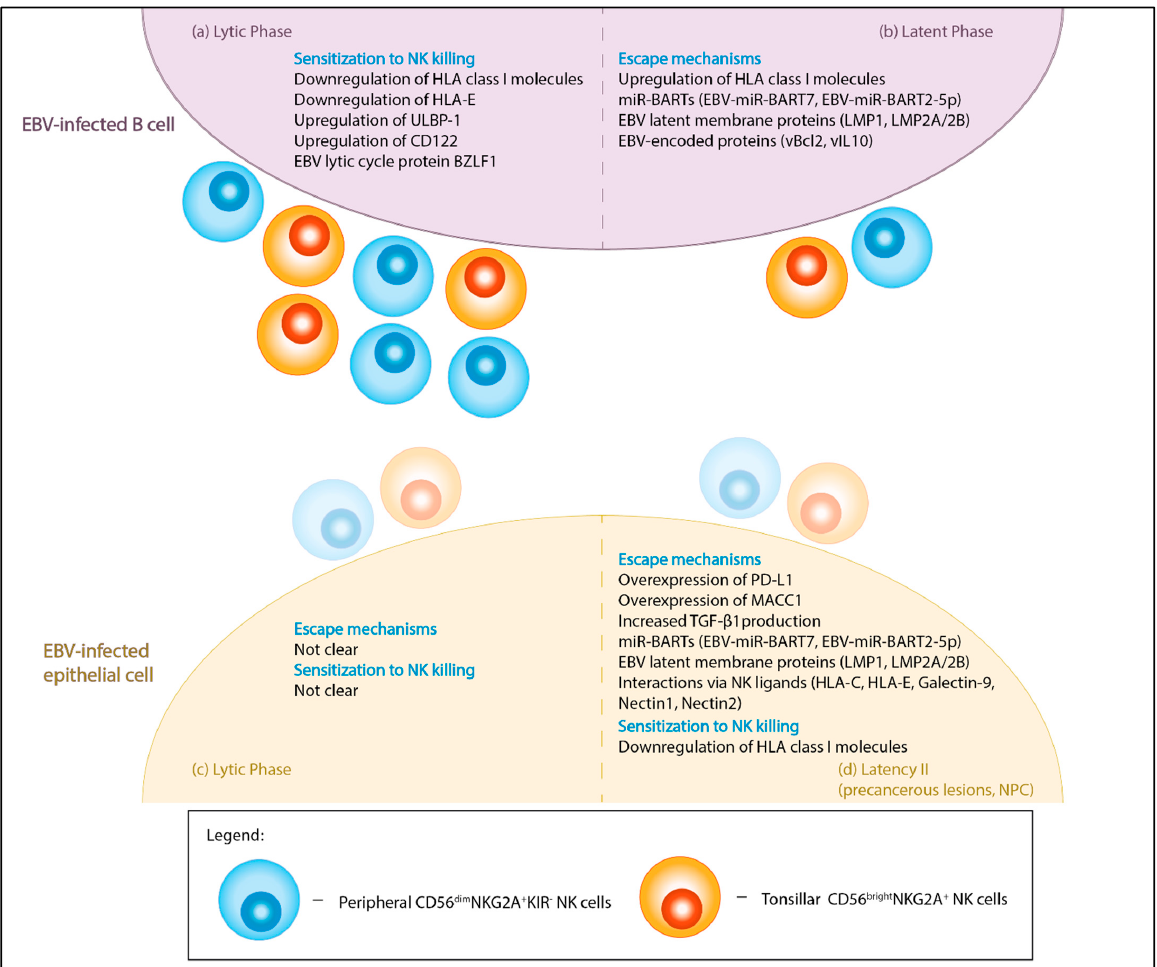
Figure 1. Graphical summary of the interactions between NK cells and EBV-infected cells. EBV infects both B cells ( a , b ) and epithelial cells ( c , d ) in either lytic or latent forms. Peripheral CD56 dim NKG2A + KIR - NK cells (blue) and tonsillar CD56 bright NKG2A + NK cells (orange) have been identified to be the main NK subset in restricting EBV-infection in B lymphocytes. The reactivity of these subsets against EBV-infected epithelial cells remains unclear. ( a ) During the lytic phase, EBV-infected B lymphocytes are more sensitized to NK killing due to changes in the expression of NK receptor ligands (HLA class I molecules, HLA-E, ULBP-1, CD122) and induction of lytic cycle protein BZLF1. ( b ) During the latent phase, there is greater NK evasion in infected B cells due to the expression of miR-BARTs, latent membrane antigens (LMP1, LMP2A/B) and other virus-encoded proteins (vBcl-2, vIL10). The miR-BARTs and LMP2A downregulate NKG2D ligands and diminish NK activation potential. The anti-apoptotic protein, vBcl2, provides protection against NK-mediated apoptosis, while pre-latent phase protein vIL-10 prevents lytic reactivation in EBV-infected tonsillar B cells. Additionally, the upregulation of HLA class I molecules can dampen NK activation through the engagement of inhibitory receptors. ( c ) EBV lytic infection in normal epithelial cells leads to cytopathy, while lytic reactivation in NPC results in genomic instability. However, how this affects evasion or sensitization to NK cells remains unclear. ( d ) In type II latency, EBV-infected epithelial cells can escape NK attack through the overexpression of PDL-1, which promote NK exhaustion and/or the overexpression of MACC1 which leads to increased TGF- β 1 production. Additionally, expression of miR-BARTs, latent membrane proteins and NK inhibitory ligands (HLA-C, HLA-E), and ligation of co-inhibitory receptors on NK (Galectin-9-TIM3, Nectin1-CD96 and Nectin2-TIGIT) may also desensitize antitumor NK responses. In contrast, the downregulation of HLA class I molecules, common in NPC, may sensitize tumor cells to NK cells due to lack of NK inhibitory ligands (“missing-self”). HLA, human leukocyte antigen; ULBP-1, UL16 binding protein 1; BZLF1, BamHI Z fragment leftward open reading frame 1; BART, BamHI-A rightward transcripts; LMP, latent membrane protein; MACC1, metastasis-associated colon cancer-1; vBcl2, viral Bcl-2 homolog; vIL10, viral interleukin-10; PDL-1, programmed cell death protein ligand 1, TGF- β 1, transforming growth factor- β 1; NKG2, natural killer group 2; TIM3, T-cell immunoglobulin and mucin domain 3; TIGIT, T cell immunoreceptor with immunoglobulin and ITIM